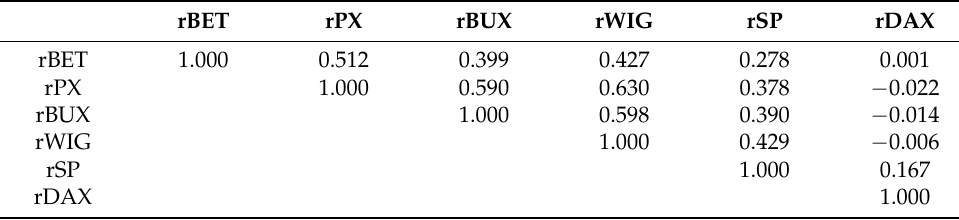
Table A3. The Pearson Correlations of European and US Stock Market Index.